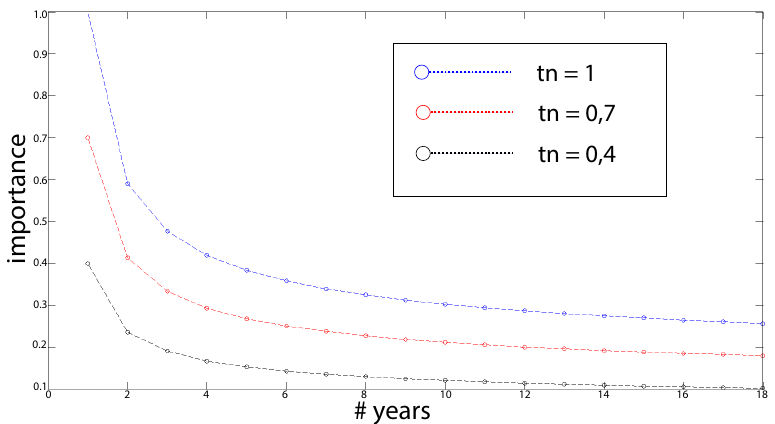
Figure 16. Logarithmic Importance